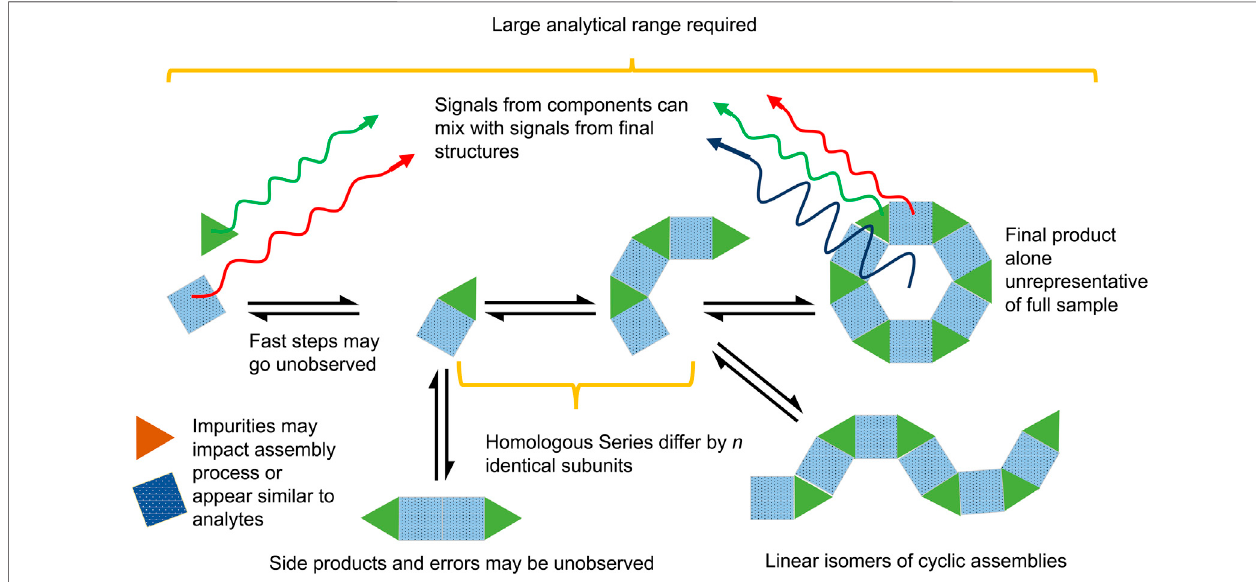
FIGURE 3 | The not-insigni fi cant challenges that must be overcome when analysing self-assembly. These include the large analytical range, mixed signals, homologous series, and variable timescales.